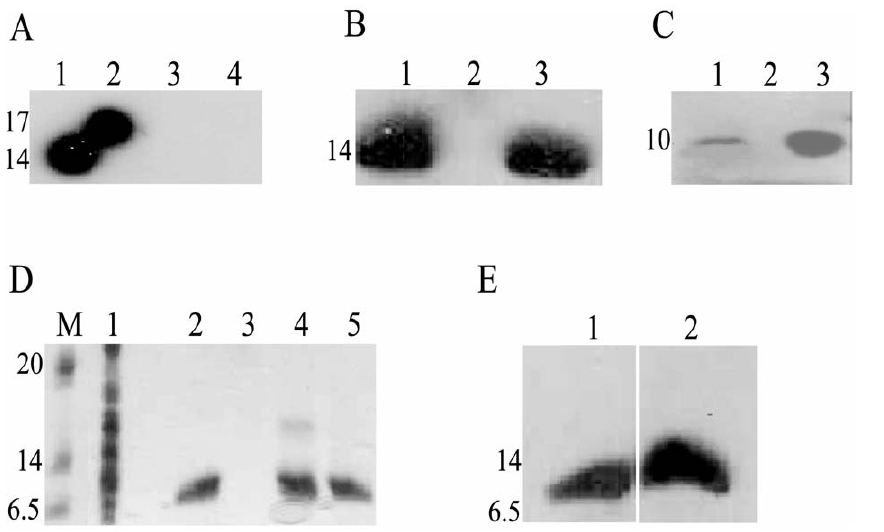
Figure 2. Interaction of HrpB2 XAC with HrcU XAC_207-357AAAH and with HrcU XAC_His277-357 . A ) Far-Western blot assays demonstrating the HrpB2 XAC interaction with immobilized HrcU XAC_207-357AAAH . The following purified proteins were separated by SDS-PAGE and transferred to a nitrocellulose membrane: Lane 1: HrpB2 XAC . Lanes 2 and 4: HrcU XAC_207-357AAAH. Lane 3: chicken muscle tropomyosin fragment Tm 143-284 [60]. Nitrocellulose strips corresponding to lanes 2 and 3 were incubated with HrpB2 followed by washing to remove unbound proteins. Nitrocellulose strips corresponding to lanes 1 to 4 were then incubated with polyclonal antiserum raised against HrpB2 XAC . The strips were rejoined and revealed using anti-mouse IgG conjugated with horseradish peroxidase. B ) Far-Western Blot assays demonstrating the HrcU XAC_207-357AAAH interaction with immobilized HrpB2 XAC . The following samples were separated by SDS-PAGE and transferred to a nitrocellulose membrane: Lysates of E. coli cells after (lane 1) and before (lane 2) expression of HrpB2 XAC and purified HrpB2 XAC (lane 3). The nitrocelulose membrane was incubated with HrcU XAC_207-357AAAH following by incubation with polyclonal antiserum raised against HrcU XAC_207-357AAAH and revealed using protein A conjugated with horseradish peroxidase. C ) Far-Western Blot assays demonstrating the HrpB2 XAC interaction with immobilized HrcU XAC_His277-357 . The following samples were separated by SDS-PAGE and transferred to a nitrocellulose membrane: Lysates of E. coli cells after (lane 1) and before (lane 2) expression of HrcU XAC_His277-357 and purified HrcU XAC_His277-357 (lane 3). The nitrocellulose membrane was incubated with HrpB2 following by incubation with polyclonal antiserum raised against HrpB2 XAC and revealed as described in part A. D ) Pull-down assay demonstrating the interaction of HrpB2 XAC with HrcU XAC_His277-357 immobilized on Ni 2 + -chelating resin. HrcU XAC_His277-357 (lane 2), HrpB2 XAC (lane 3), a HrpB2 XAC plus HrcU XAC_His277-357 mixture (lane 4) and a mixture of HrcU XAC_His277-357 with an E. coli BL21(DE3) cell lysate (lane 5) were applied to a Ni 2 + -chelating resin, washed with buffer containing 25 mM imidazole and bound proteins were eluted by washing with 500 mM imidazole. Eluted proteins were separated by SDS-PAGE and visualized by Coomassie brilliant blue staining. Lane 1 shows the contents of the E. coli lysate employed in lane 5. Molecular mass markers (M) are shown to the left in kilodaltons. E ) Since HrpB2 XAC and HrcU XAC_His277-357 are not easily separated by SDS-PAGE, the presence of both HrpB2 XAC and HrcU XAC_His277-357 in the bound fraction shown in lane 4 of Figure 2D was demonstrated by Western blot using polyclonal antisera raised against HrcU XAC_207-357AAAH (lane 1) and against HrpB2 XAC (lane 2). The masses of molecular weight markers (in kDa) are indicated to the left of parts A-E.